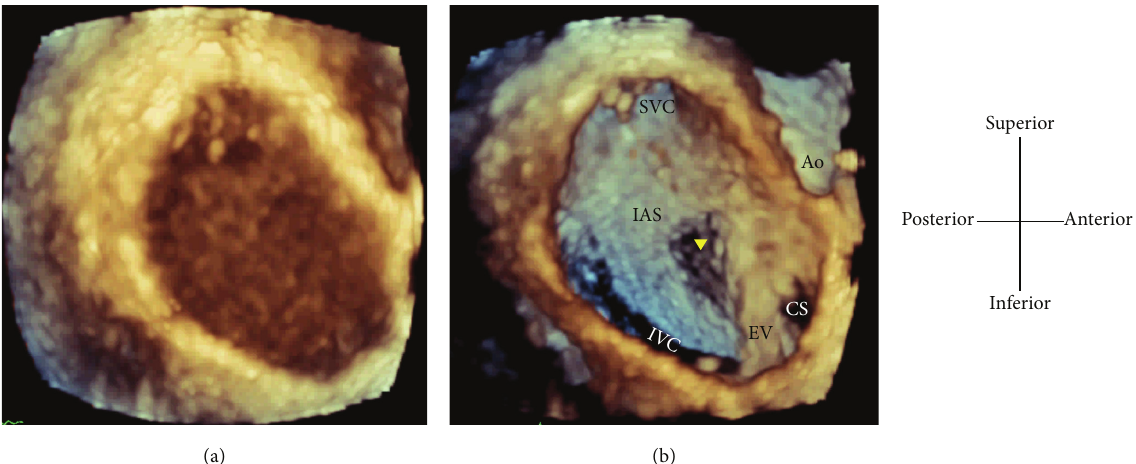
Figure 2: Reducing the gain will remove the blood signals and will allow clear identification of the right atrial structures, for example, SVC opening, IVC opening, Eustachian valve (EV), coronary sinus (CS) opening, and aortic root (Ao). Further gain reduction will cause dropout artifact in the thin area of the fossa ovalis (arrow head) that will help determining its location to guide septal puncture.